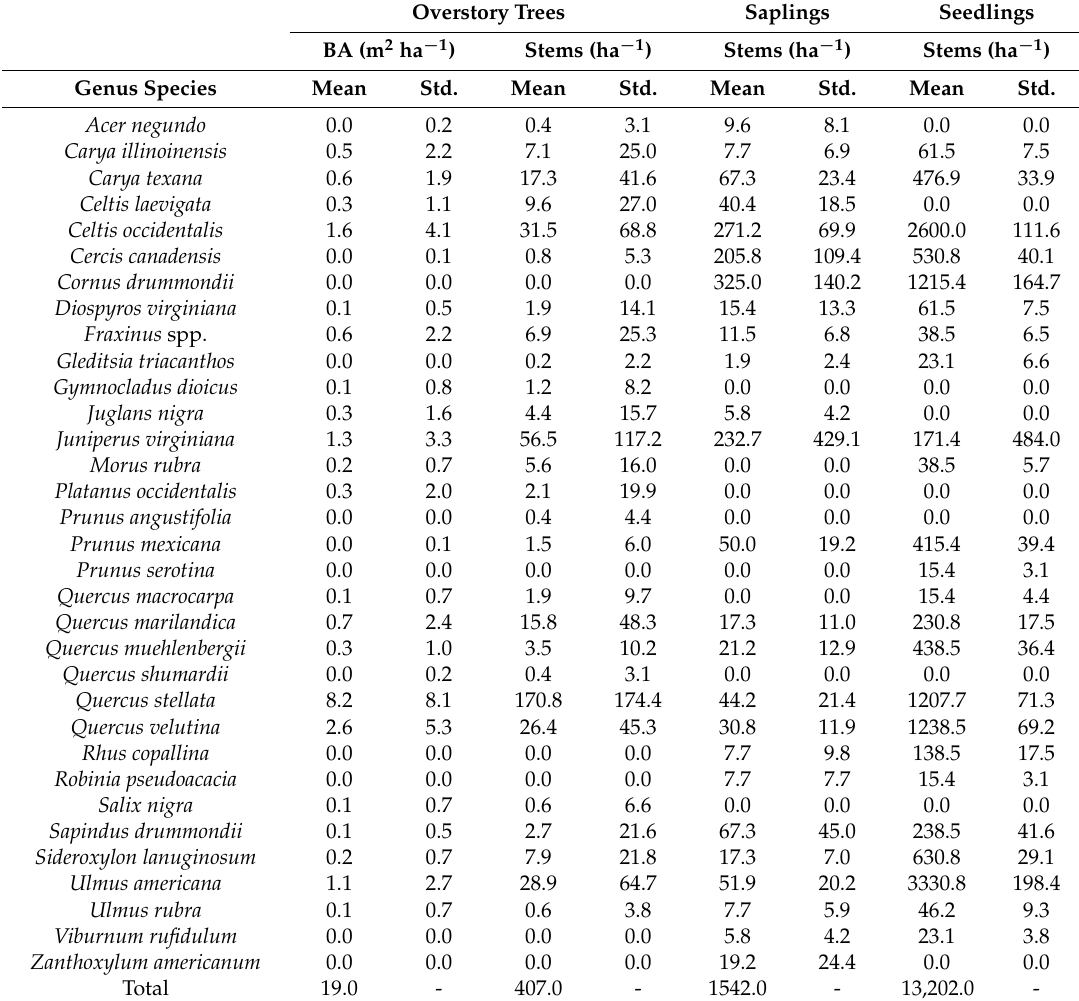
Table 2. Average basal area (BA) and density for overstory trees (dbh >10 cm) and average density for sapling (dbh 0.1 to 10 cm) and seedlings (shorter than 1.37 m) measured in 130 plots in Cross Timbers forests of north-central Oklahoma. Std. = standard deviation. For seedlings, all Celtis spp. are considered Celtis occidentalis